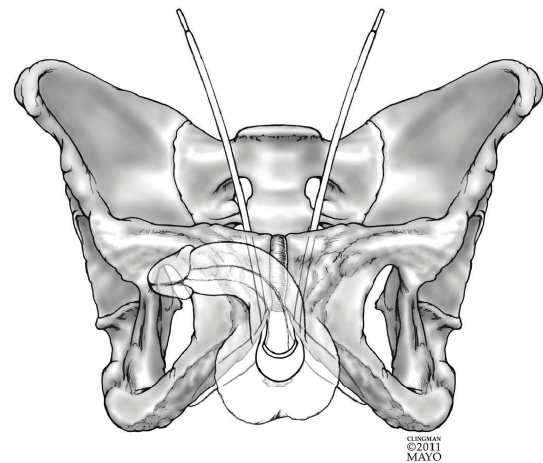
Figure 3: Graphical representation of the adjustable retropubic